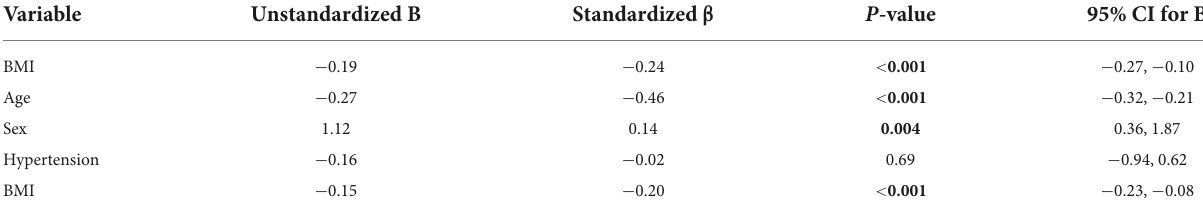
TABLE 3 Linear regression models predicting GM volumes. Variable Unstandardized